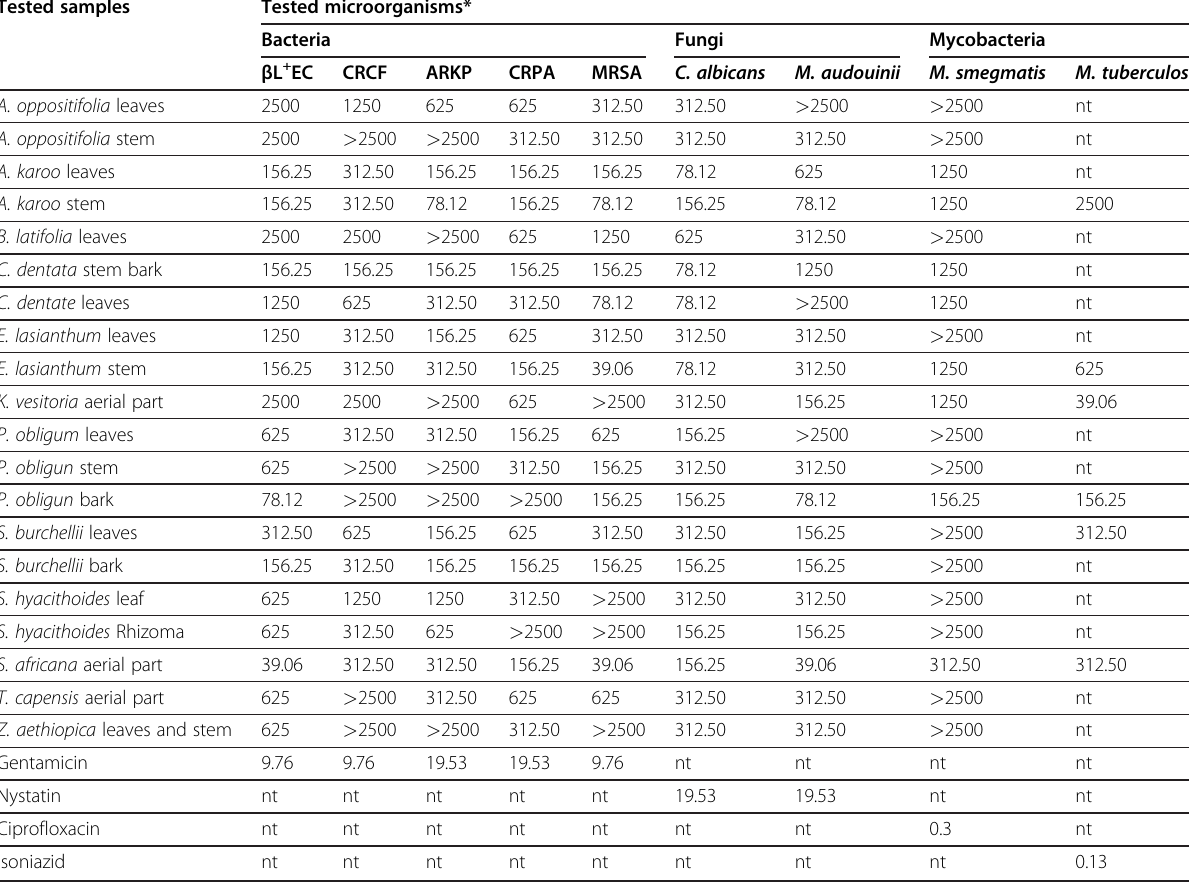
Table 2 Minimal inhibition concentration ( μ g/ml) of the crude extracts and reference antibiotics Tested